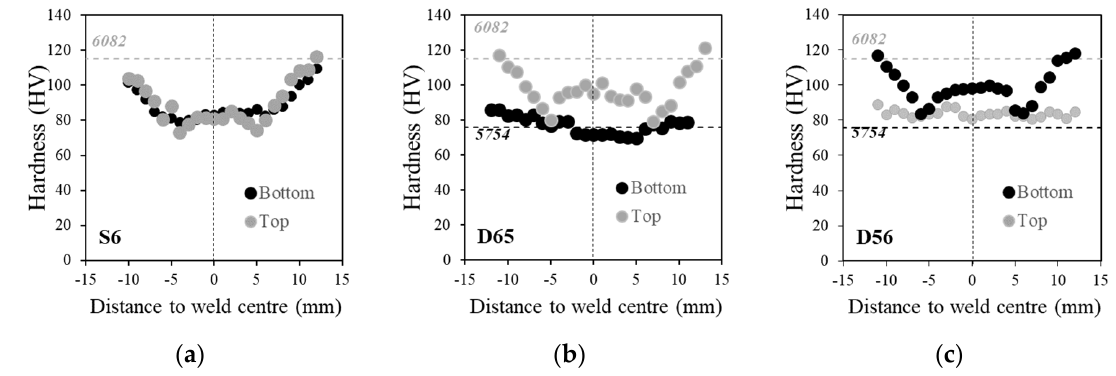
Figure 7. Microhardness profiles registered along the transverse cross-section of the welds: ( a ) S6, ( b ) D65 and ( c ) D56.